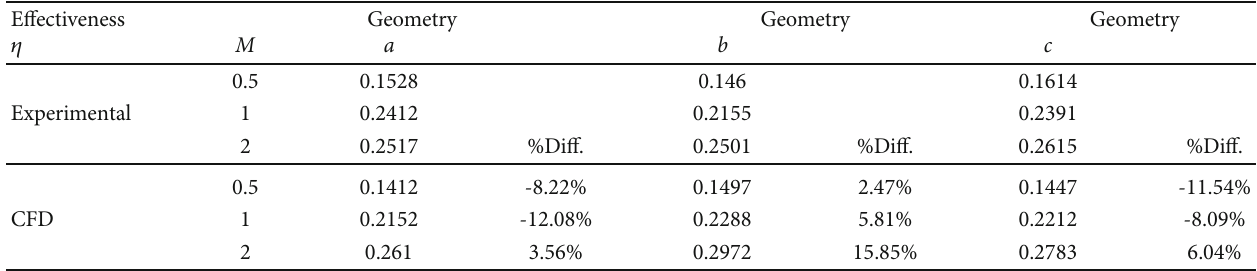
Figure 15: Laterally averaged fi lm e ff ectiveness for M = 2 . Table 1: Area-averaged e ff